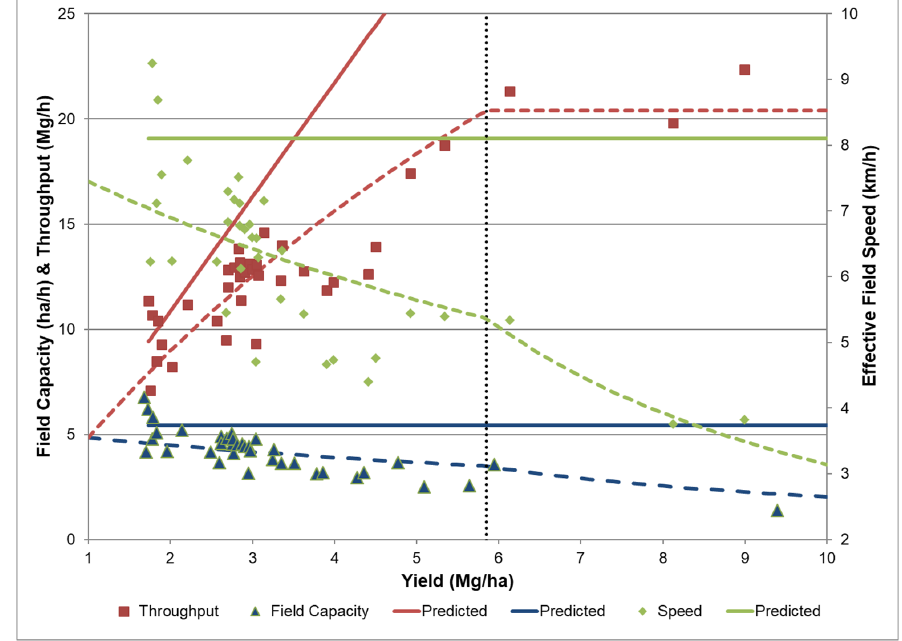
Figure 4. Data from field observations [3] compared with Equations (1), (2), (4), and (6) and assuming operating conditions of: W = 6.7 m, v = 10.9 km/h, E f = 0.74, C mx = 30.8 Mg/h, Y c = 5.6 Mg/ha, B m = 0.52 Mg, and t w = 32 s.